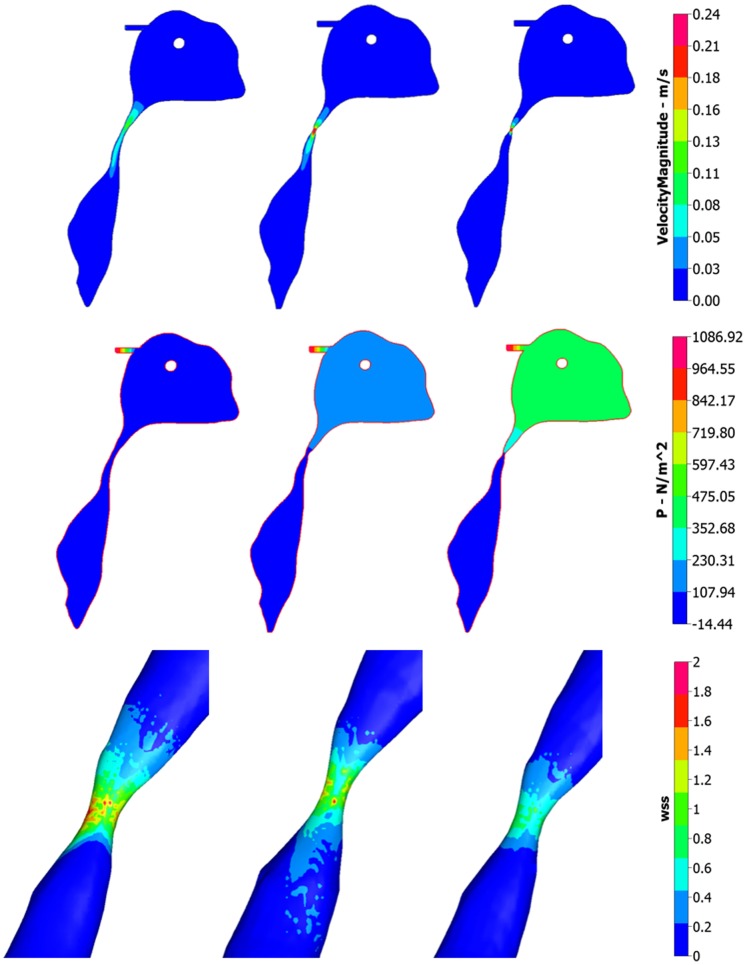
Comparing velocity magnitude, pressure (P) and Wall shear stress (WSS) for varying aqueductal stenosis.(First row) Sagittal view of the unobstructed, mild and severely stenosed aqueduct within the ventricular cavities. The contour lines denote velocity magnitude. Precise values for peak velocity within the aqueduct at the aforementioned stenosis levels can be found in Table 2. (Second Row) Pressure distribution of an extended ventricular region accompanying the open, mild and severely stenosed aqueducts. (Third row) WSS distribution of the mild, severe and mild with applied ETV cases of aqueductal stenosis. CFD-VIEW was used to obtain velocity magnitude, pressure and WSS. All plots taken at t = 15s.